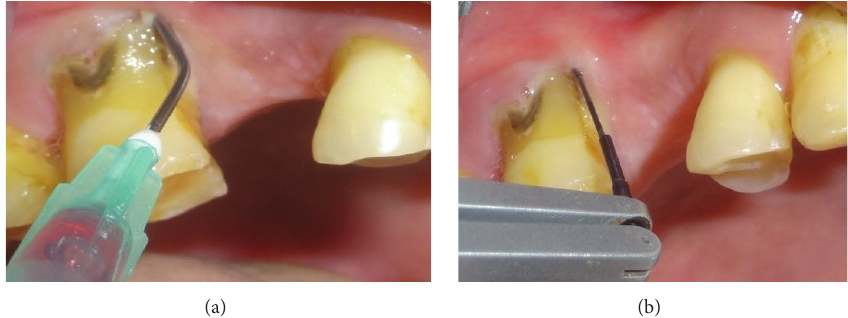
Figure 4: (a) Administration of 20% benzocaine gel. (b) Administration of 20% benzocaine gel, followed by Florida probing.